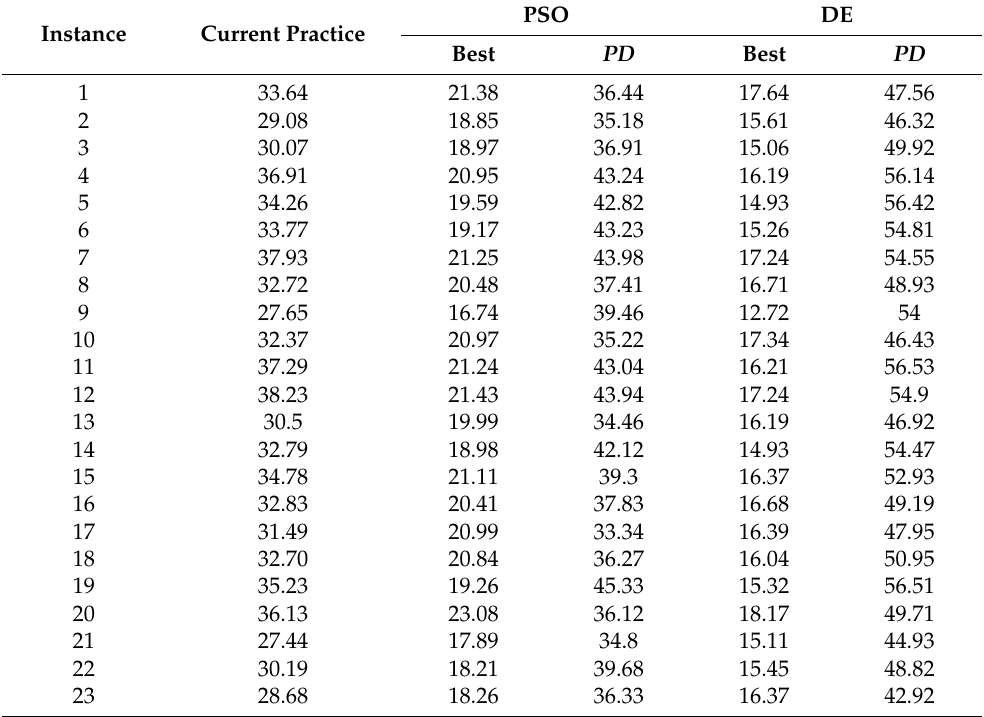
Table 4. Experimental results of the percentage deviation ( PD